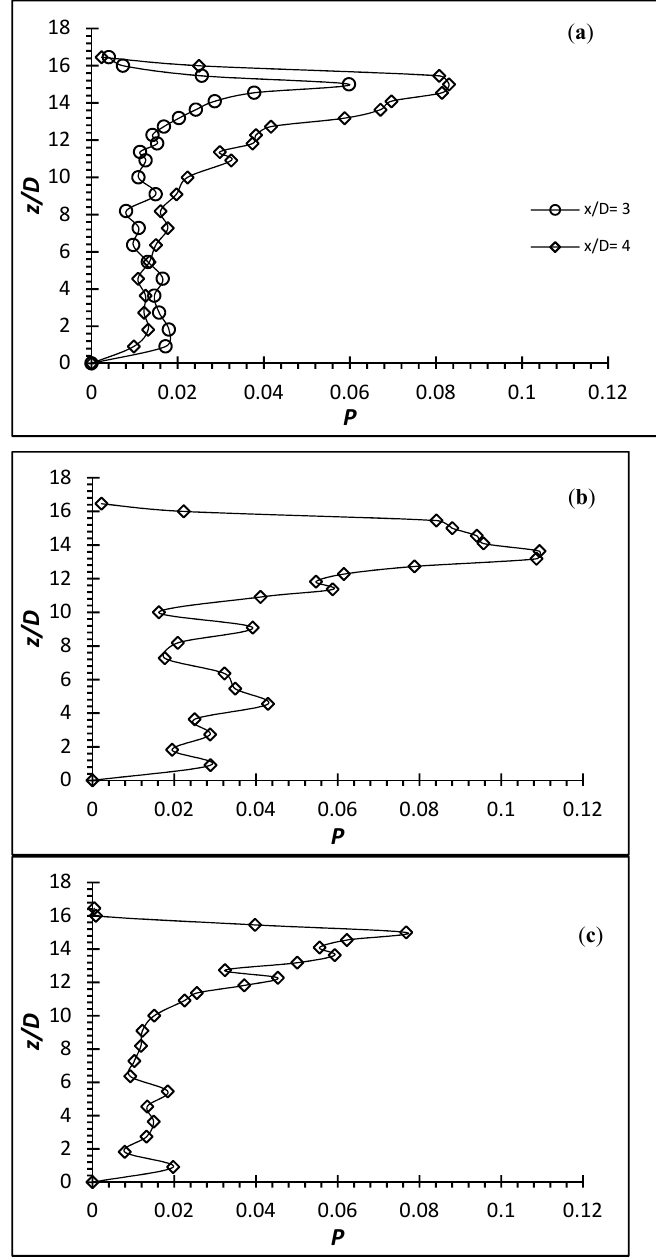
∂ U i u (cid:48) for flexible cylinder of AR = 16 at ( a ) Re = 4000; ( b ) Re = 6000; for flexible cylinder of AR = 16 at ( a ) Re = 4000; ( b ) Re = 6000; i j ∂ x j (cid:3105)(cid:3051) (cid:3285)